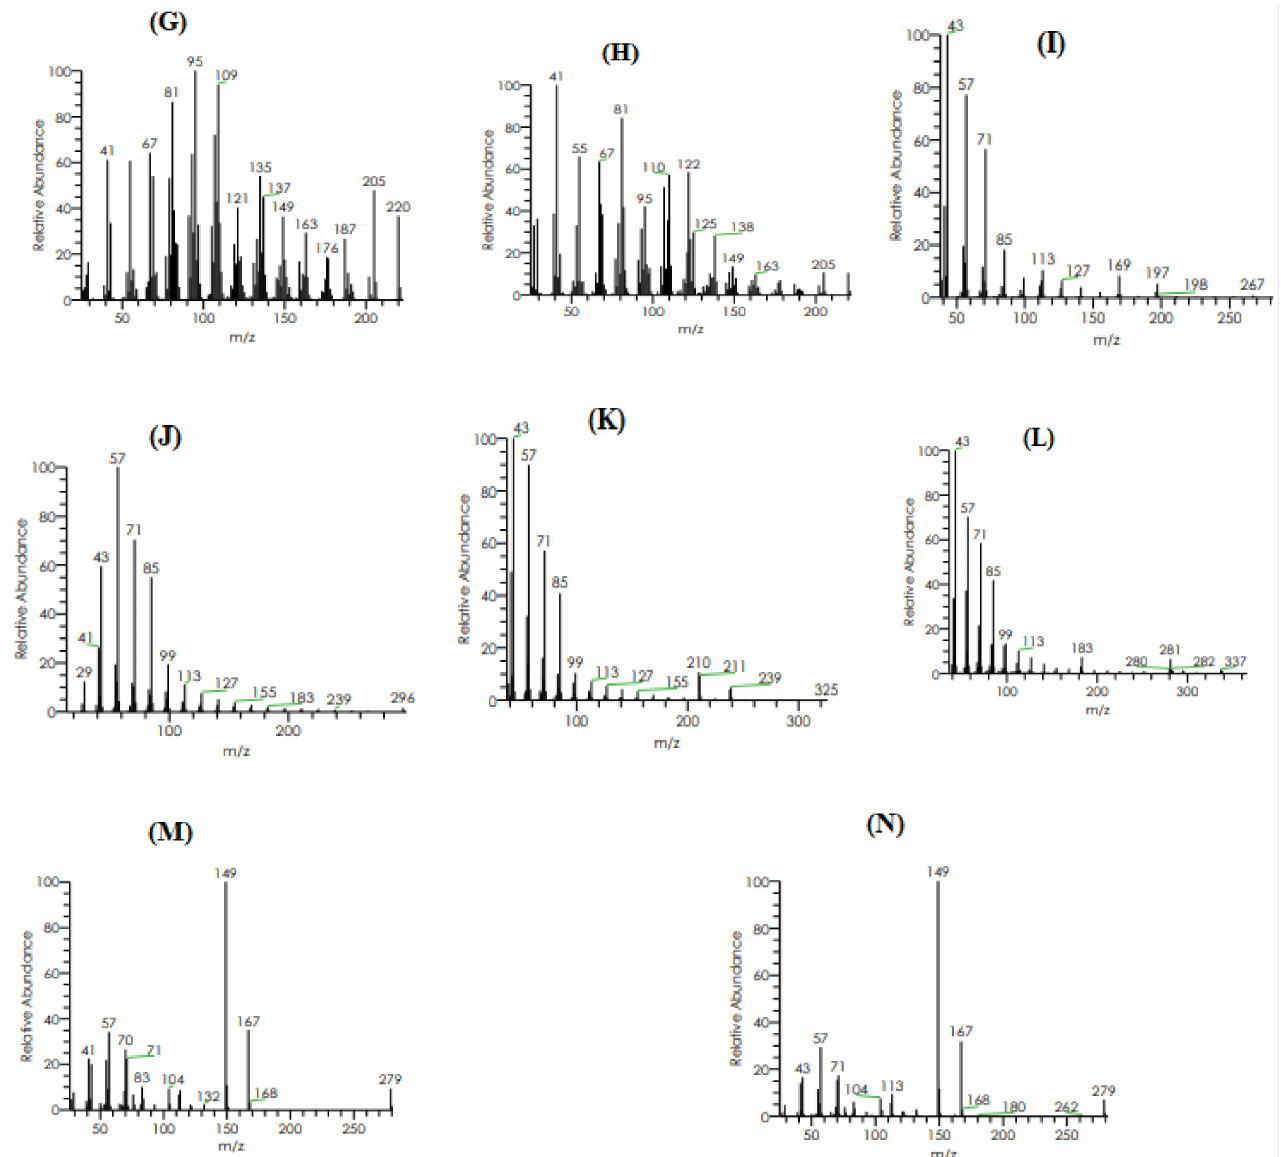
Figure 4. GC–MS chromatograms of detected compounds: ( A ) 2,6,10-Trimethylpentadecane, ( B ) Phenol,2,4-bis(1,1-dimethylethyl), ( C ) Isolongifolene,4,5,9,10-dehydro, ( D )